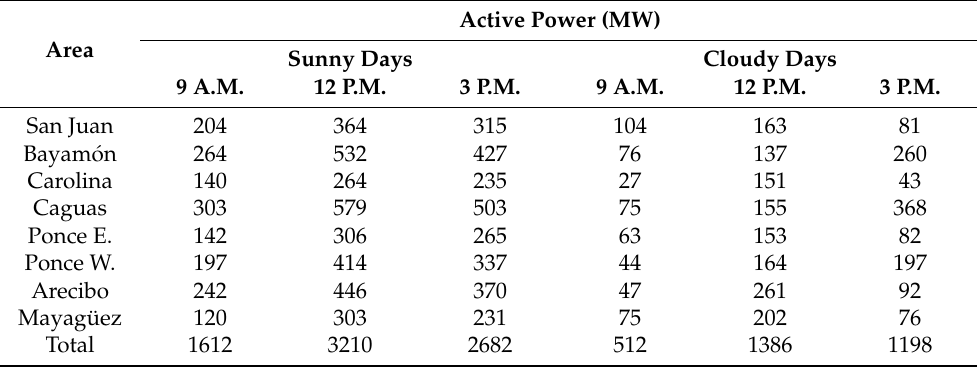
Table 17. Potential PV production by area (40% of PV